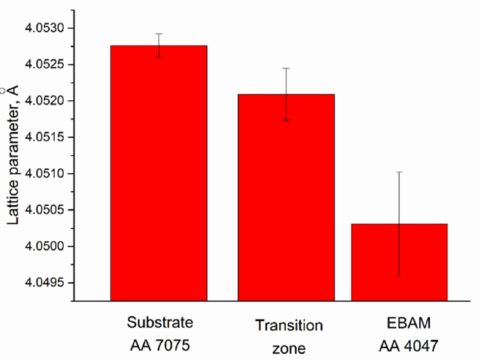
Figure 7. Solid solution lattice parameter as determined for AA7075 substrate, AA7075/AA4047 transition zone and deposited